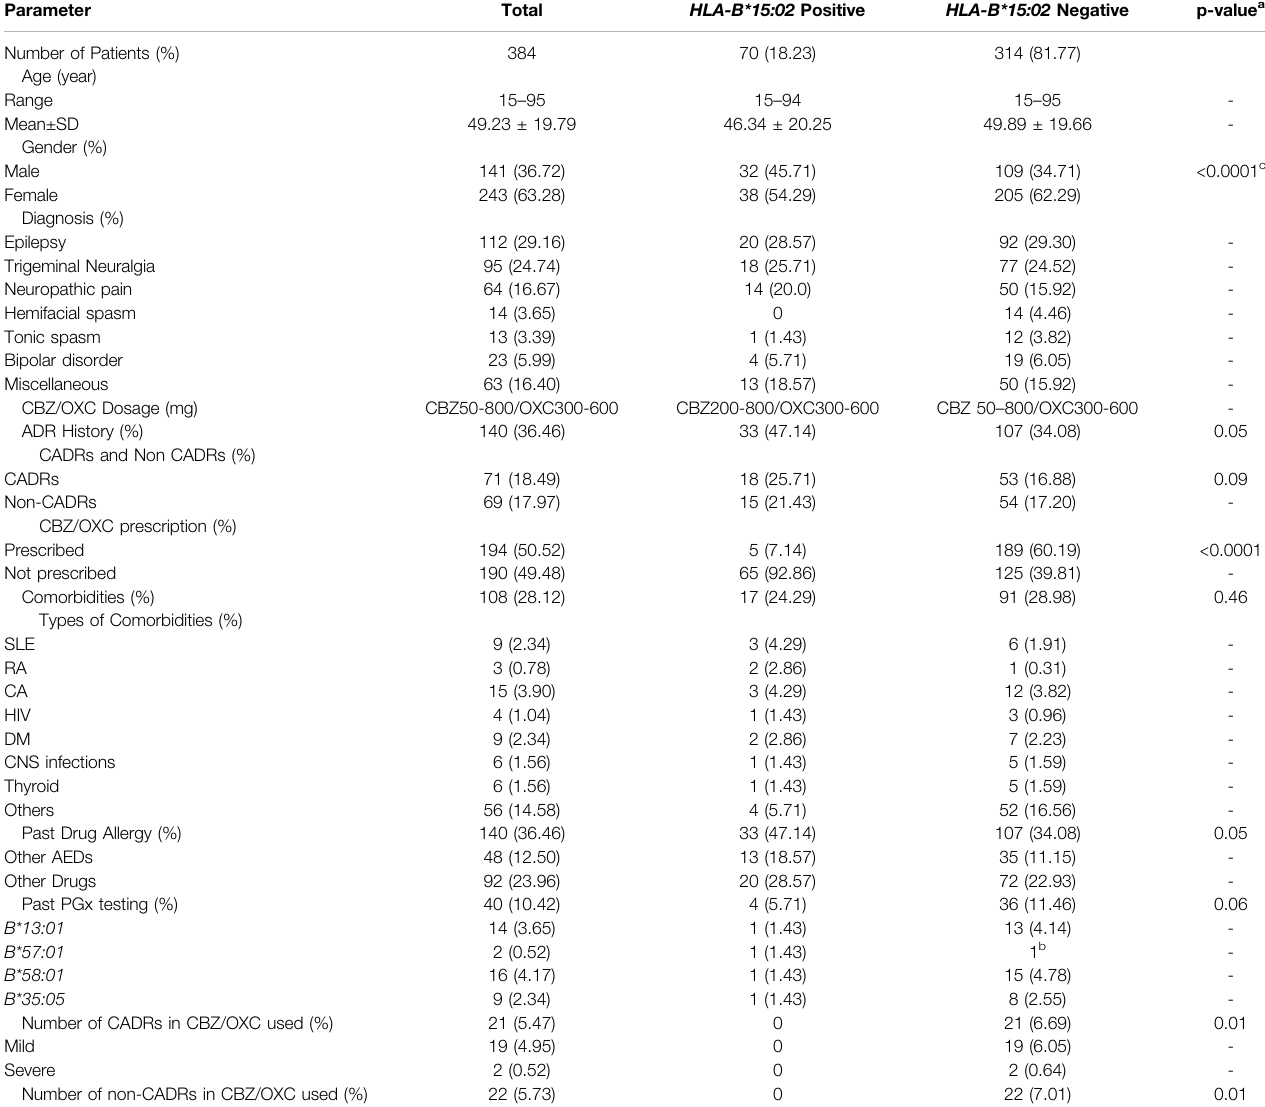
TABLE 1 | Patients characteristics, diagnosis, comorbidities, adverse drug reactions (ADRs), drug allergy. Parameter